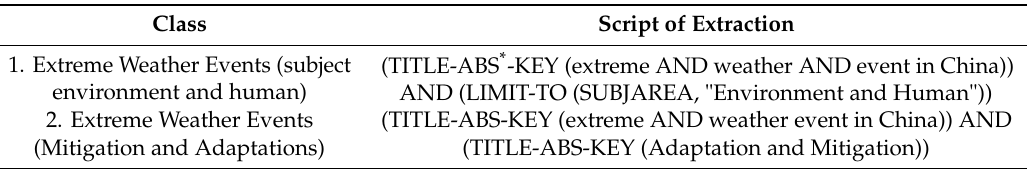
Table 1. The scripts used to extract.